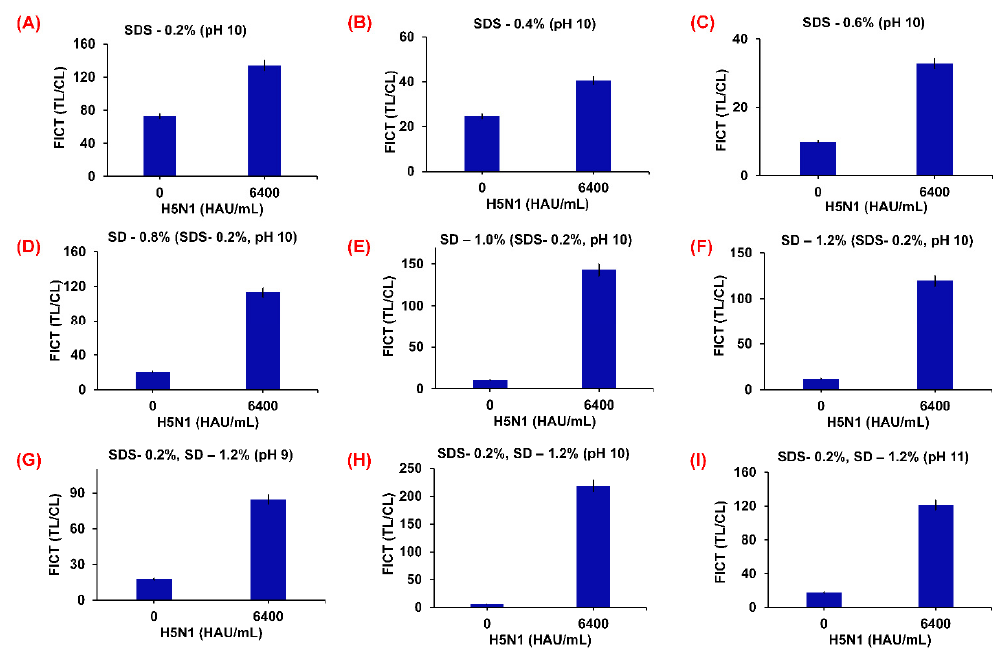
Figure 7. Optimization of lysis buffer for Cys Au-Eu nanocomposite-FICT. Various concentrations of SDS (0.2, 0.4, and 0.6%), SD (0.8, 1.0, and 1.2%) at different pH (9, 10, and 11) were tested in basic lysis buffer (0.1 M Tris, 0.1 M EDTA, and 1% Triton X-100). Basic lysis buffer was dissolved at three different SDS concentrations ( A – C ); 0.2% SDS was dissolved in lysis buffers of different SD concentrations ( D – F ) at pH 10; 0.2% SDS and 1.2% SD was dissolved in lysis buffers at different pH ( G – I ).